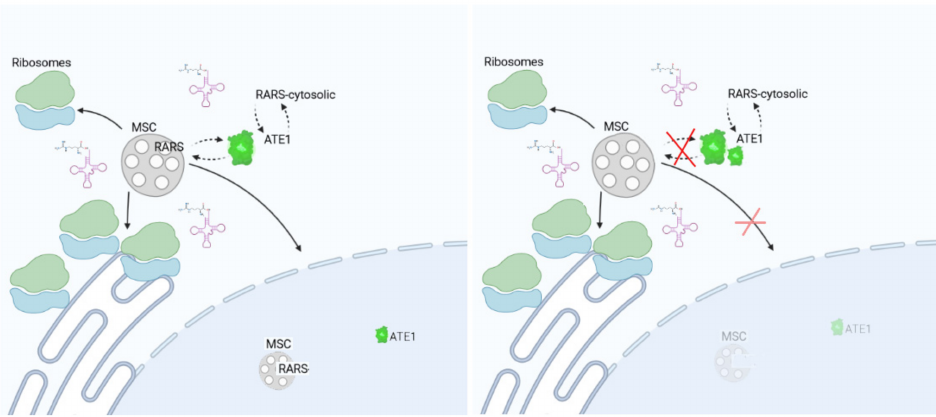
Figure 7. Interplay between ATE1 and RARS. In wild-type cells ( left ), ATE1 exists in a balance with free and MSC-bound RARS. Knockout of the leucine zipper ( right ) that scaffolds the long RARS to the MSC perturbs this balance by reducing the nuclear MSC and ATE1 localization, resulting in an increase in cytoplasmic ATE1 activity. Cytosolic and nuclear environments are denoted with white and blue backgrounds,